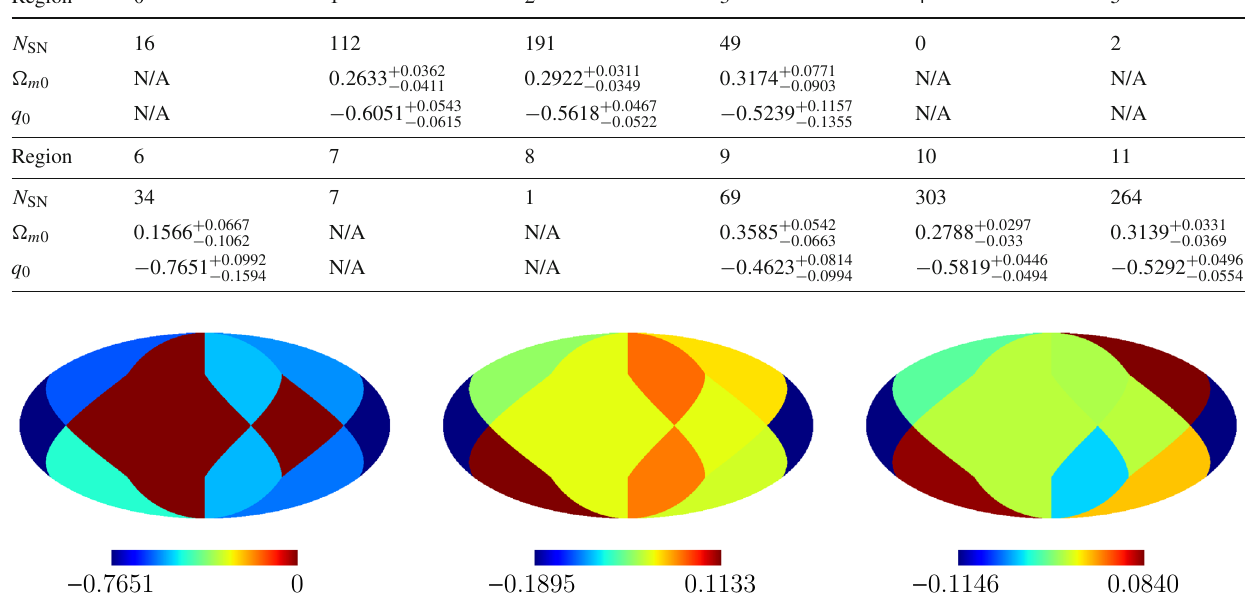
Table 1 The number of SNIa, and the best-fit (cid:8) m 0 , q 0 with 1 σ uncertainties for each region Region